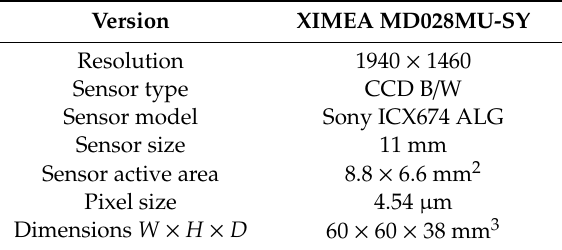
Figure 3. Machine vision measurement module. Table 1. Some technical parameters of the CCD